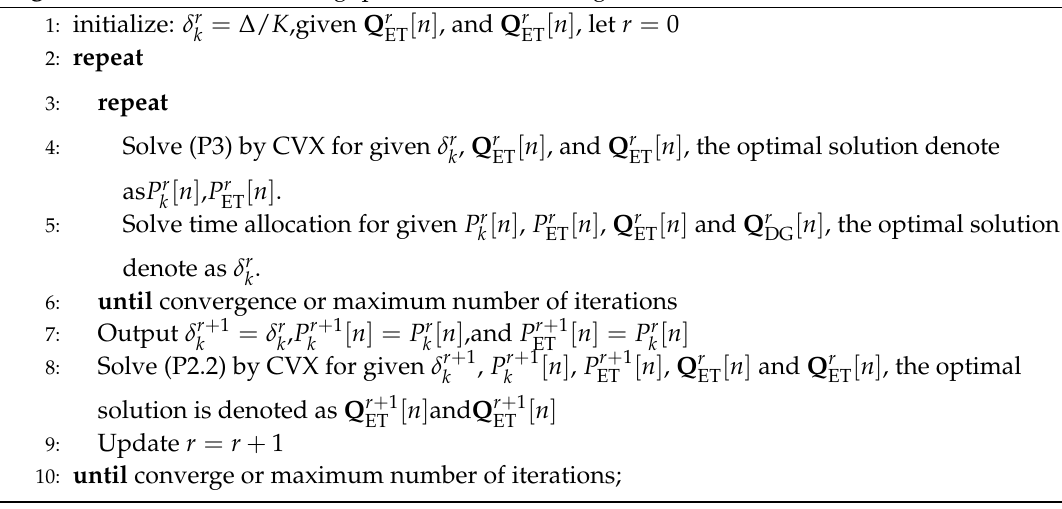
Algorithm 1: Minimum-throughput Maximization